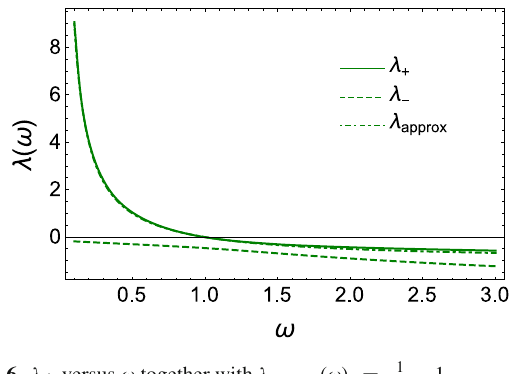
Fig. 6 λ ± versus ω together with λ approx (ω) = 1 ω −